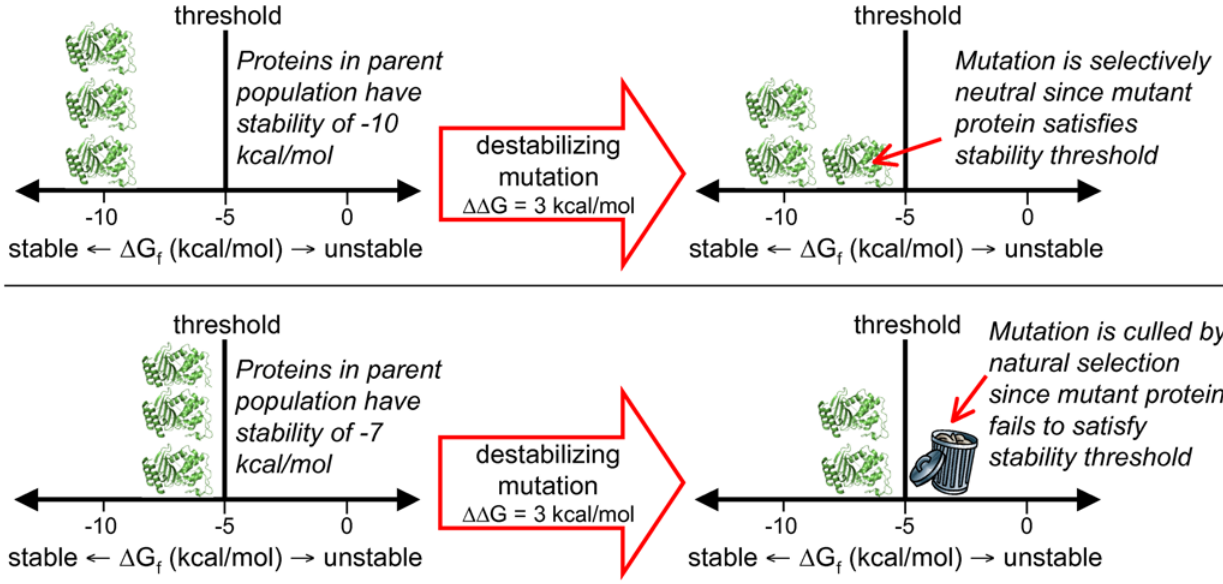
Figure 1. A stability threshold model of protein evolution. Proteins are assumed to be functional if and only if they are more stable than some ~{ 5 kcal = mol , which is a typical value for natural proteins [53]; note that more stable proteins have minimal threshold (in the figure, D G threshold f more negative D G f values). When a particular destabilizing mutation ( DD G ~ 3 kcal = mol ) occurs, the evolutionary result will depend on the stability of the proteins in the parent population. When the parent proteins are sufficiently stable (top panel), the mutant protein still satisfies the threshold, and so the mutation has the opportunity to spread by neutral genetic drift. But when the parent proteins are not sufficiently stable (bottom panel), the mutant protein fails to stably fold, and is eliminated by natural selection. Therefore, the probability that a mutation that induces a stability change of DD G will have an opportunity to spread by neutral genetic drift is simply the probability that the parent protein has a stability { DD G . D G f v D G threshold f